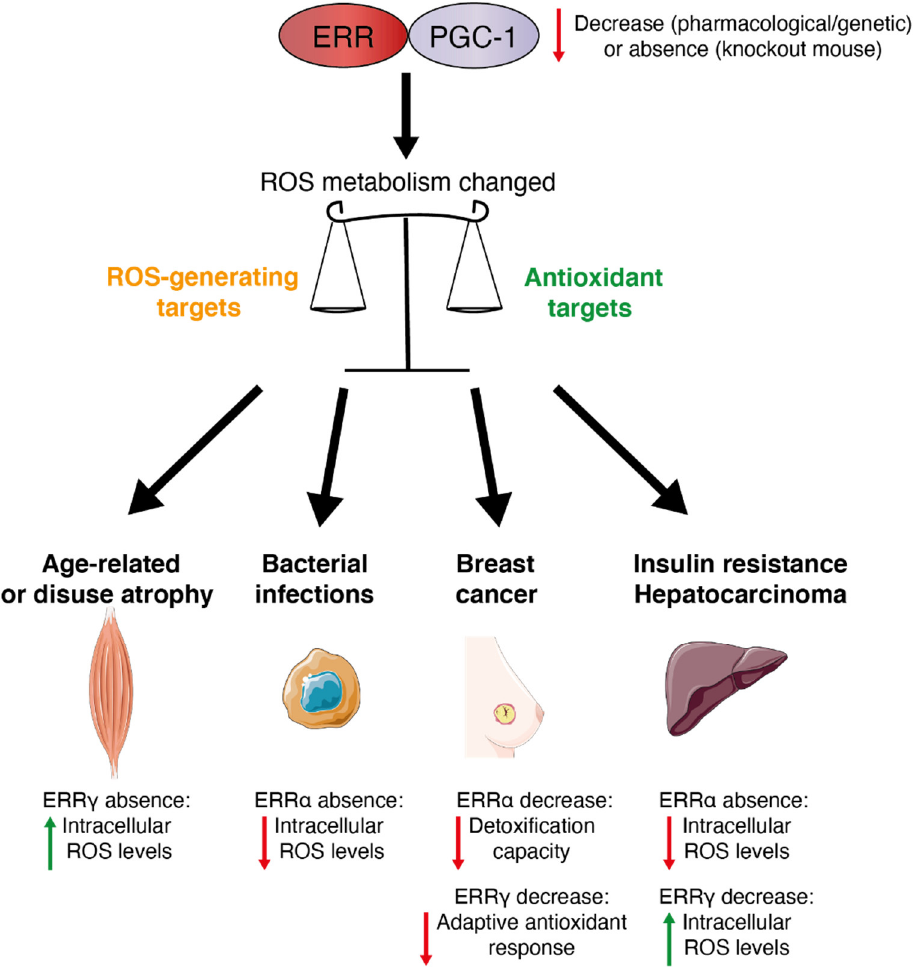
Figure 3. The PGC-1/ERR axis: a redox medicine strategy. The PGC-1/ERR axis plays a role in the balance of ROS metabolism and can be an attractive target to manage several oxidative stress-related physiopathologies. Red arrows indicate a decrease, green arrows indicate an increase.